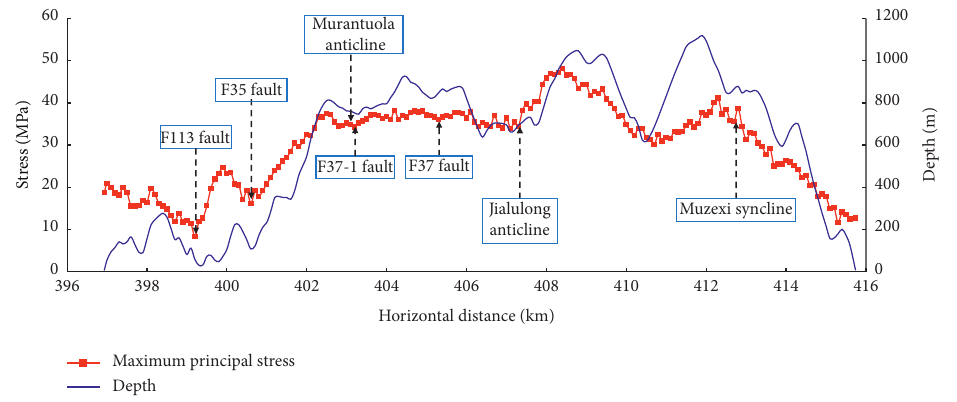
Figure 9: In situ stress variation of the tunnel